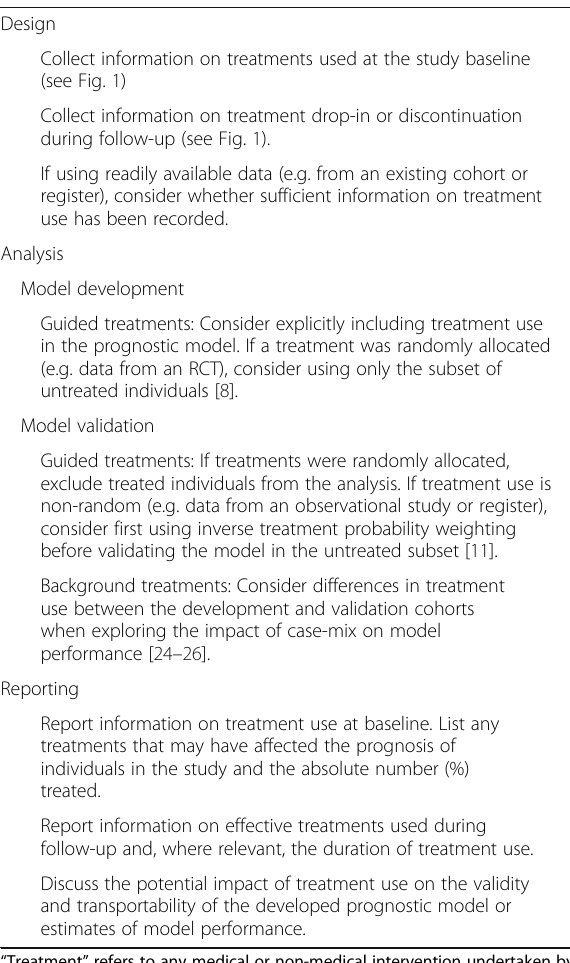
Table 4 Addressing and reporting treatment use in prognostic model